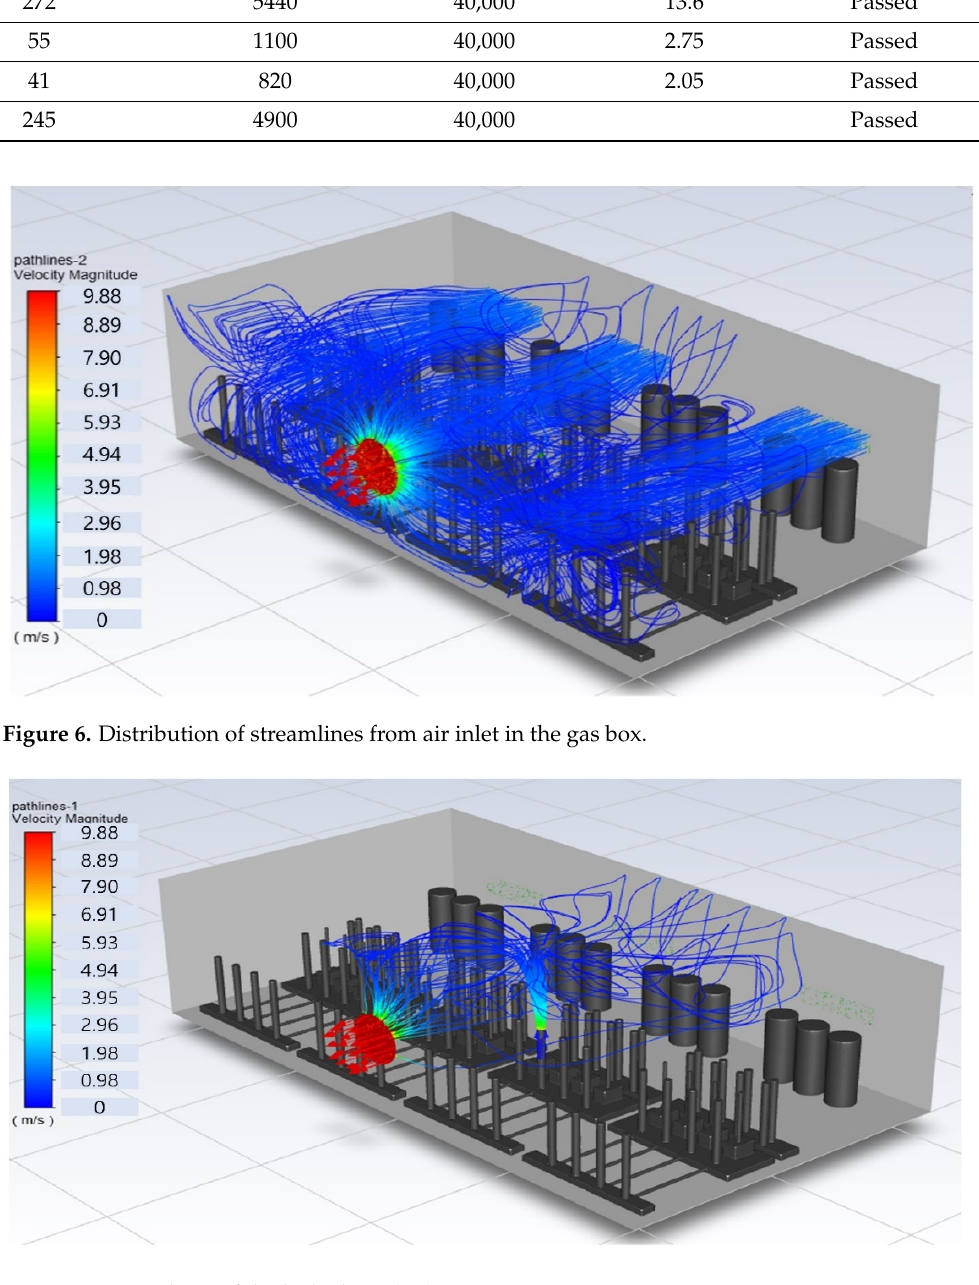
Figure 7. Streamlines of the leaked gas (H ₂ ). Table 7. Identified X, Y, and Z positions on YZ, XZ, and XY sections, respectively.